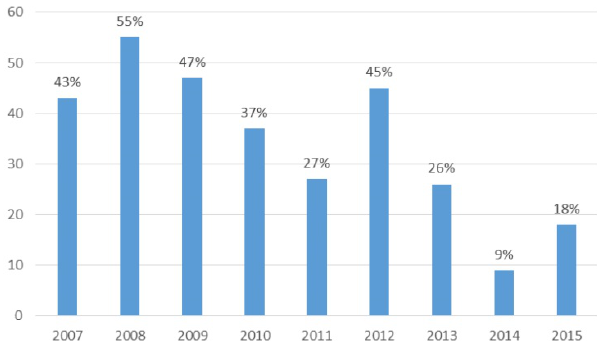
Figure 1. Temporal evolution of the carbapenem susceptibility profile of A. baumannii complex strains causing osteomyelitis during the study period.